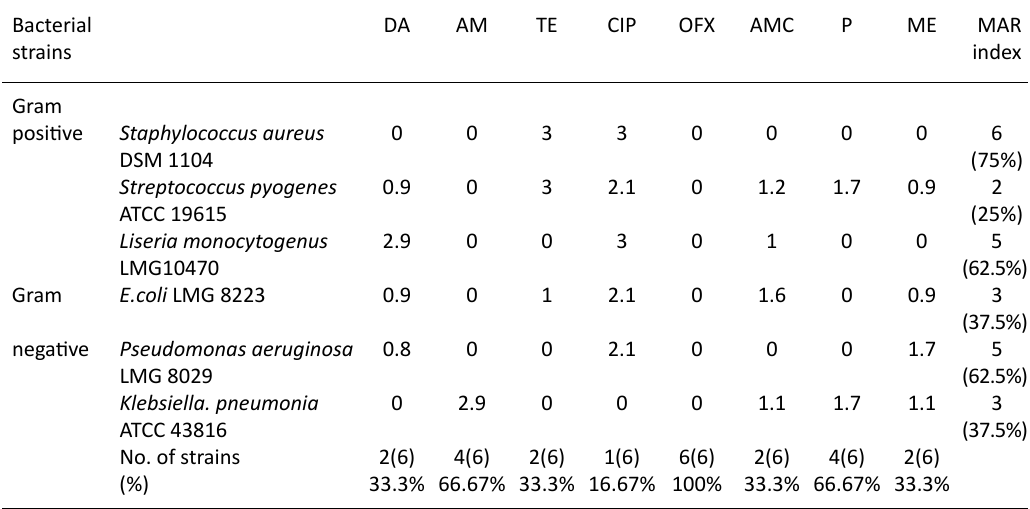
Table 1. Antibiotic sensitivity test of the studied bacteria based on the diameter of inhibition zone (mm) Bacterial DA AM TE CIP strains Gram positive